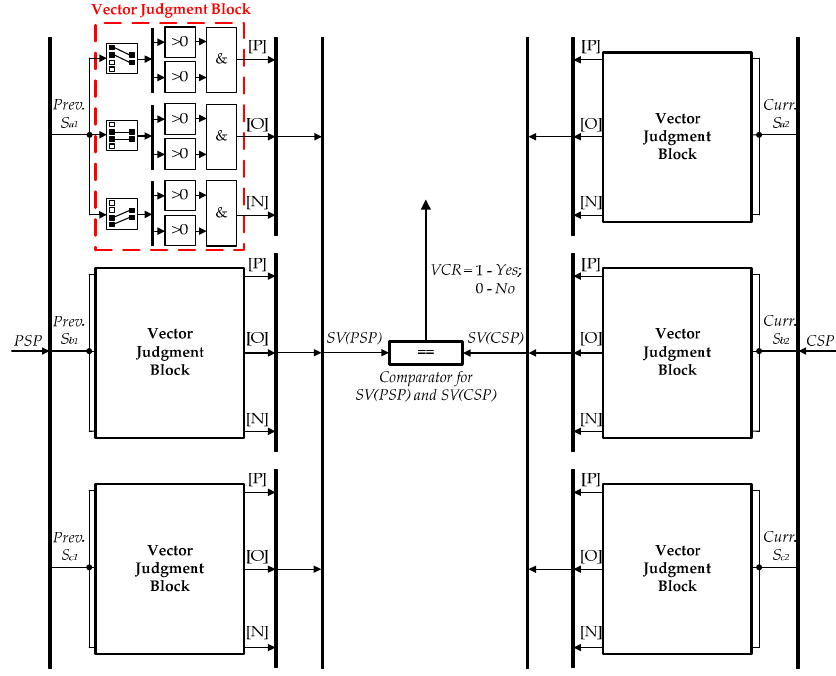
Figure 5. Intuitive details of the block “Comparator”.